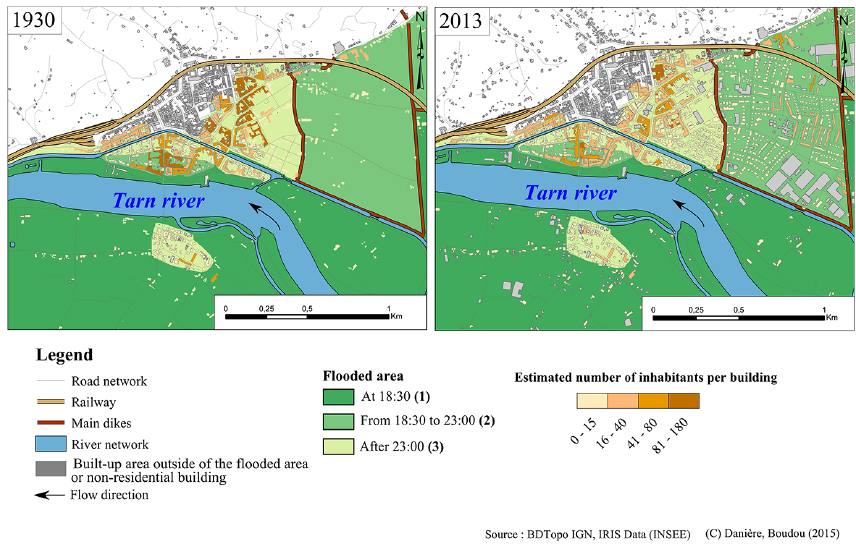
Figure 11. Estimated number of inhabitants per building within the area affected by the 1930 flood in Moissac: (a) in 1930 and (b) in